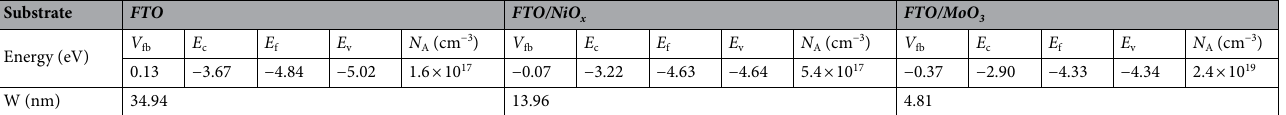
Table 4. Information on Mott-Schottky analysis for CISe films deposited on a different